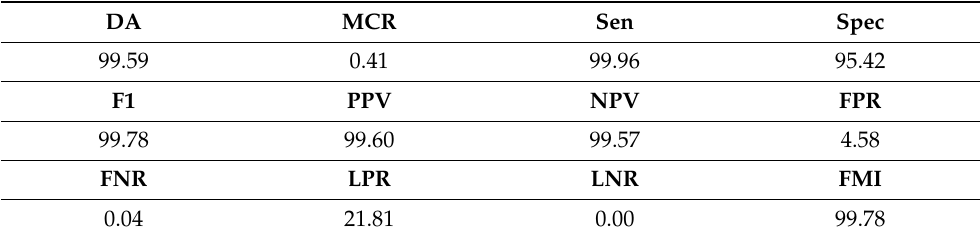
Table 4. Performance Analysis of SVM (%) During Training Phase.